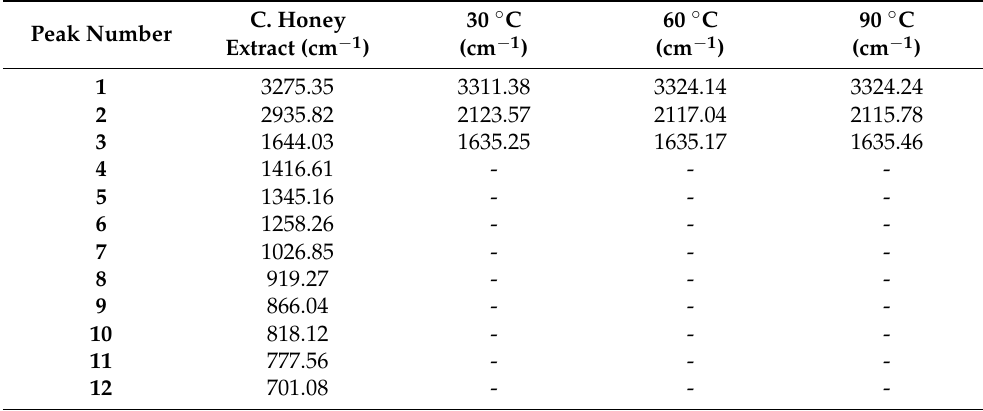
Table 2. The list of FTIR